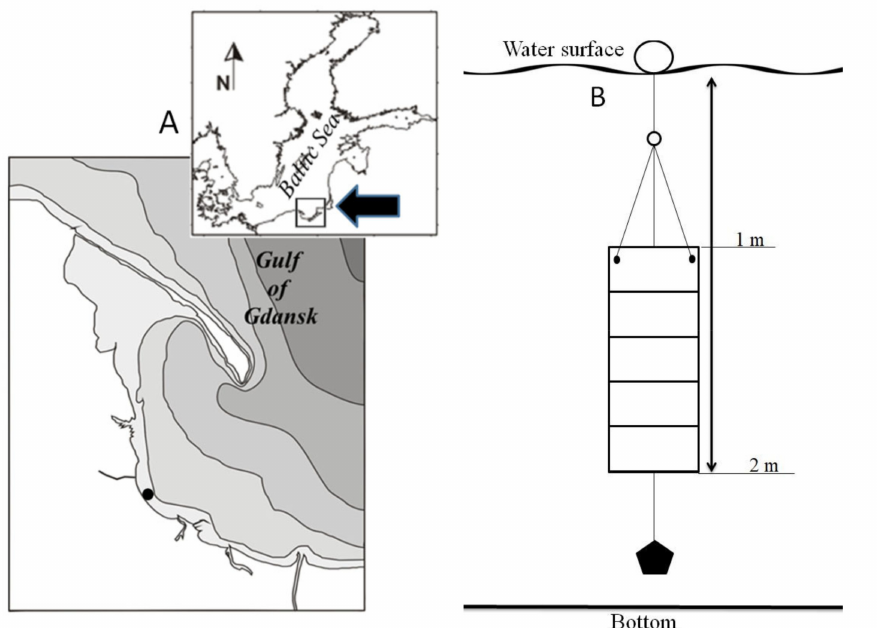
Figure 1. ( A ) Location of the station where the culture panel was exposed to the waters of the Gulf of Gda´nsk. Inset shows the location of the Gulf of Gda´nsk in the Baltic Sea. ( B ) Diagram of the culture panel exposed to the waters of the Gulf of